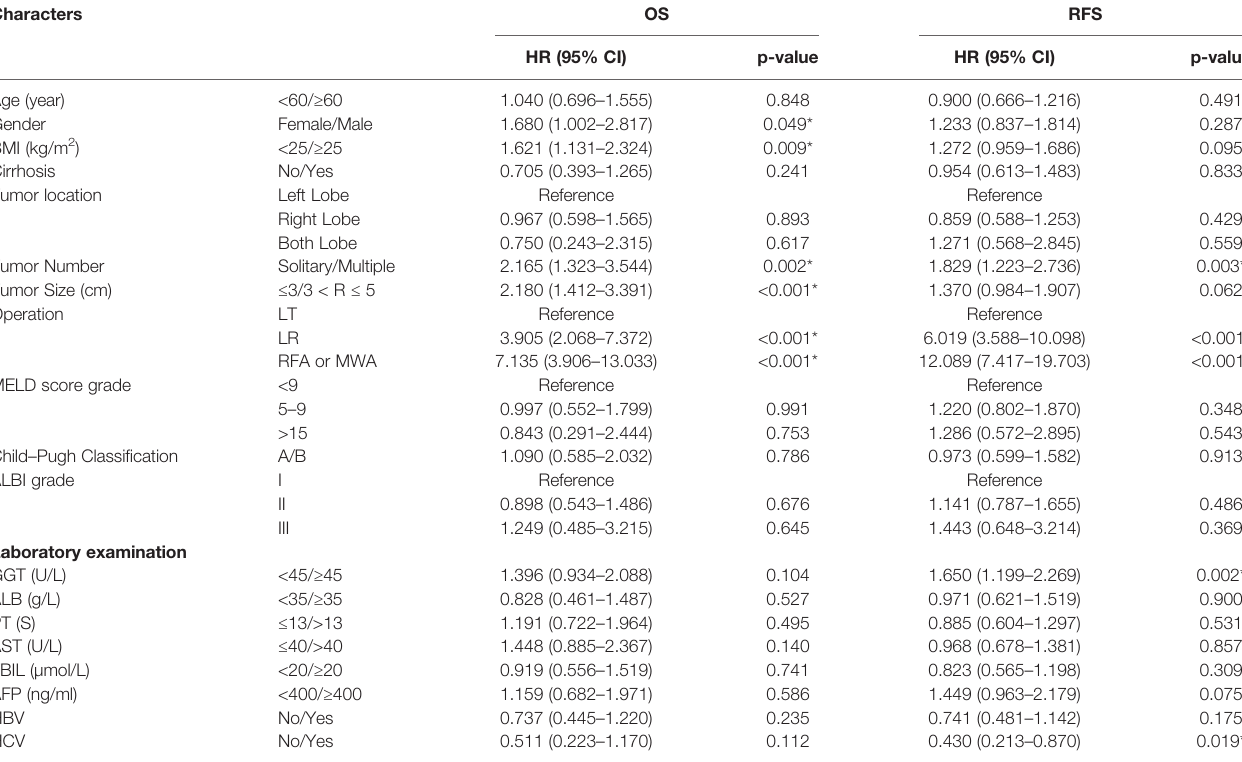
TABLE 2 | Multivariate analyses for OS and RFS in patients with 512 HCC (training